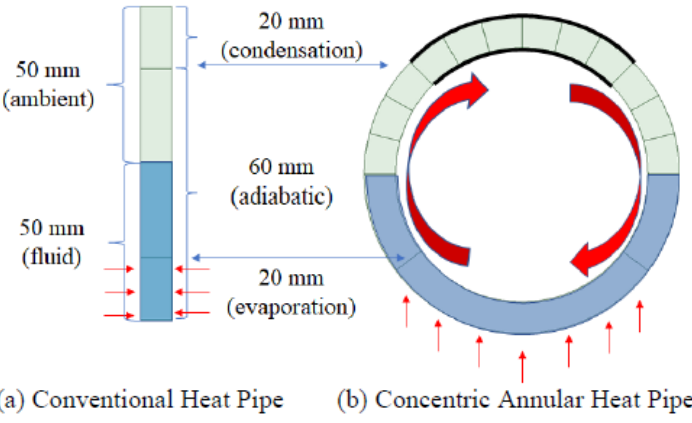
Figure 4. Geometries of 2D modeling.